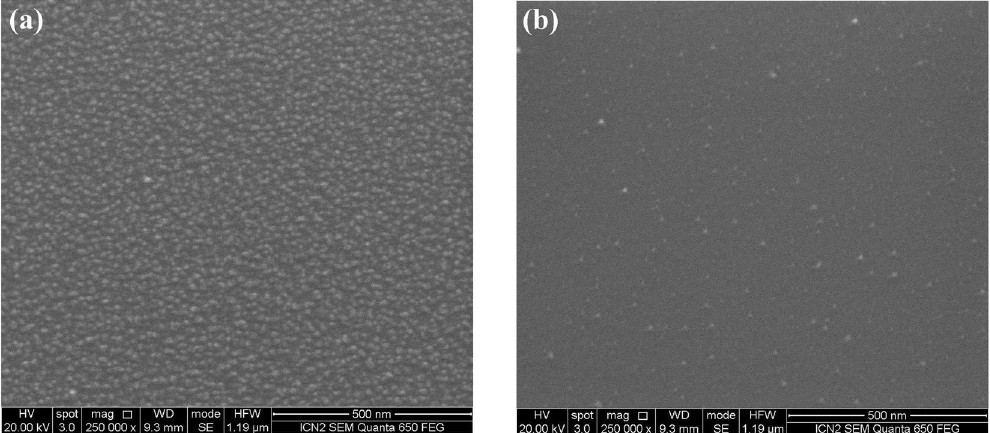
Figure 12. SEM images of B 4 C-coated test wafers taken at 20 kV electron acceleration voltage with a 250k-fold magnification after cleaning with pure O 2 plasma: ( a ) Formerly a-C coated part, and ( b ) non a-C coated part.